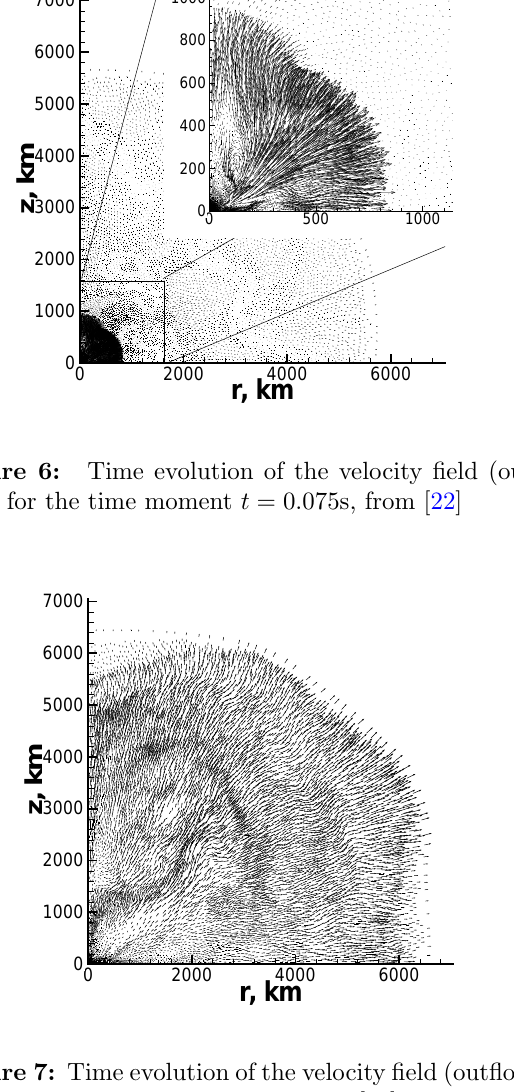
Figure 7: Time evolution of the velocity field (outflow) for the time moment, t = 0 . 25 s , from [22].